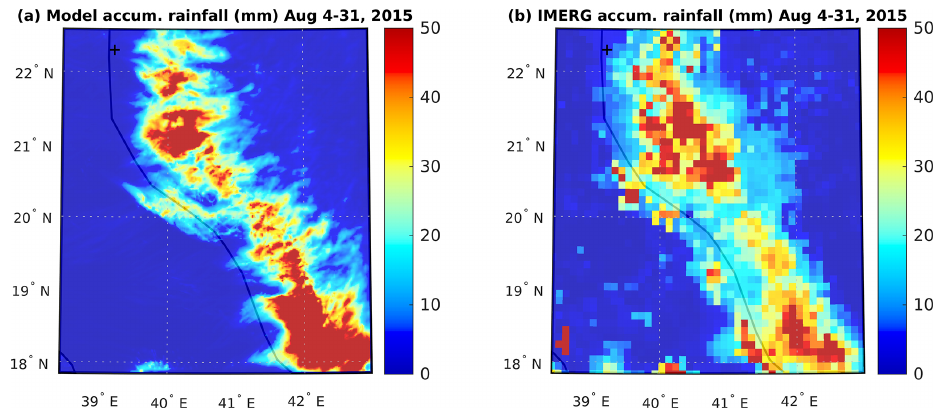
Figure 5. Spatial distribution of accumulated rainfall (4–31 August 2015) (a) model and (b) IMERG data. The location of KAUST is marked by a plus sign.